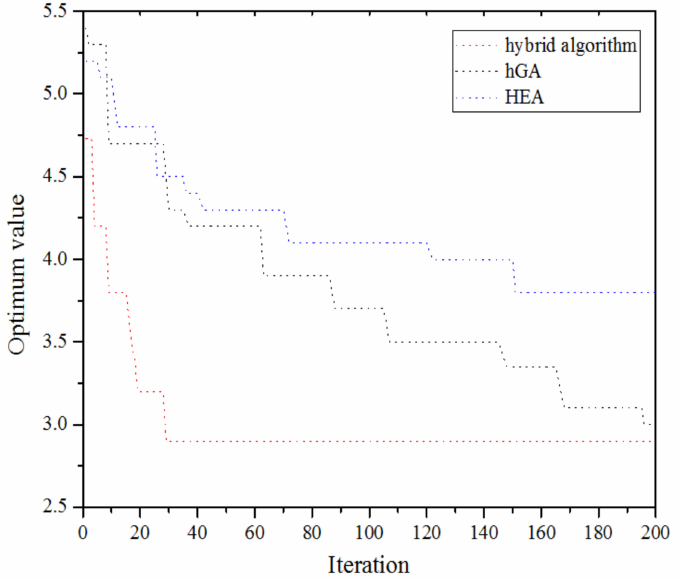
Figure 9. Comparison with mentioned hybrid algorithms for optimizing